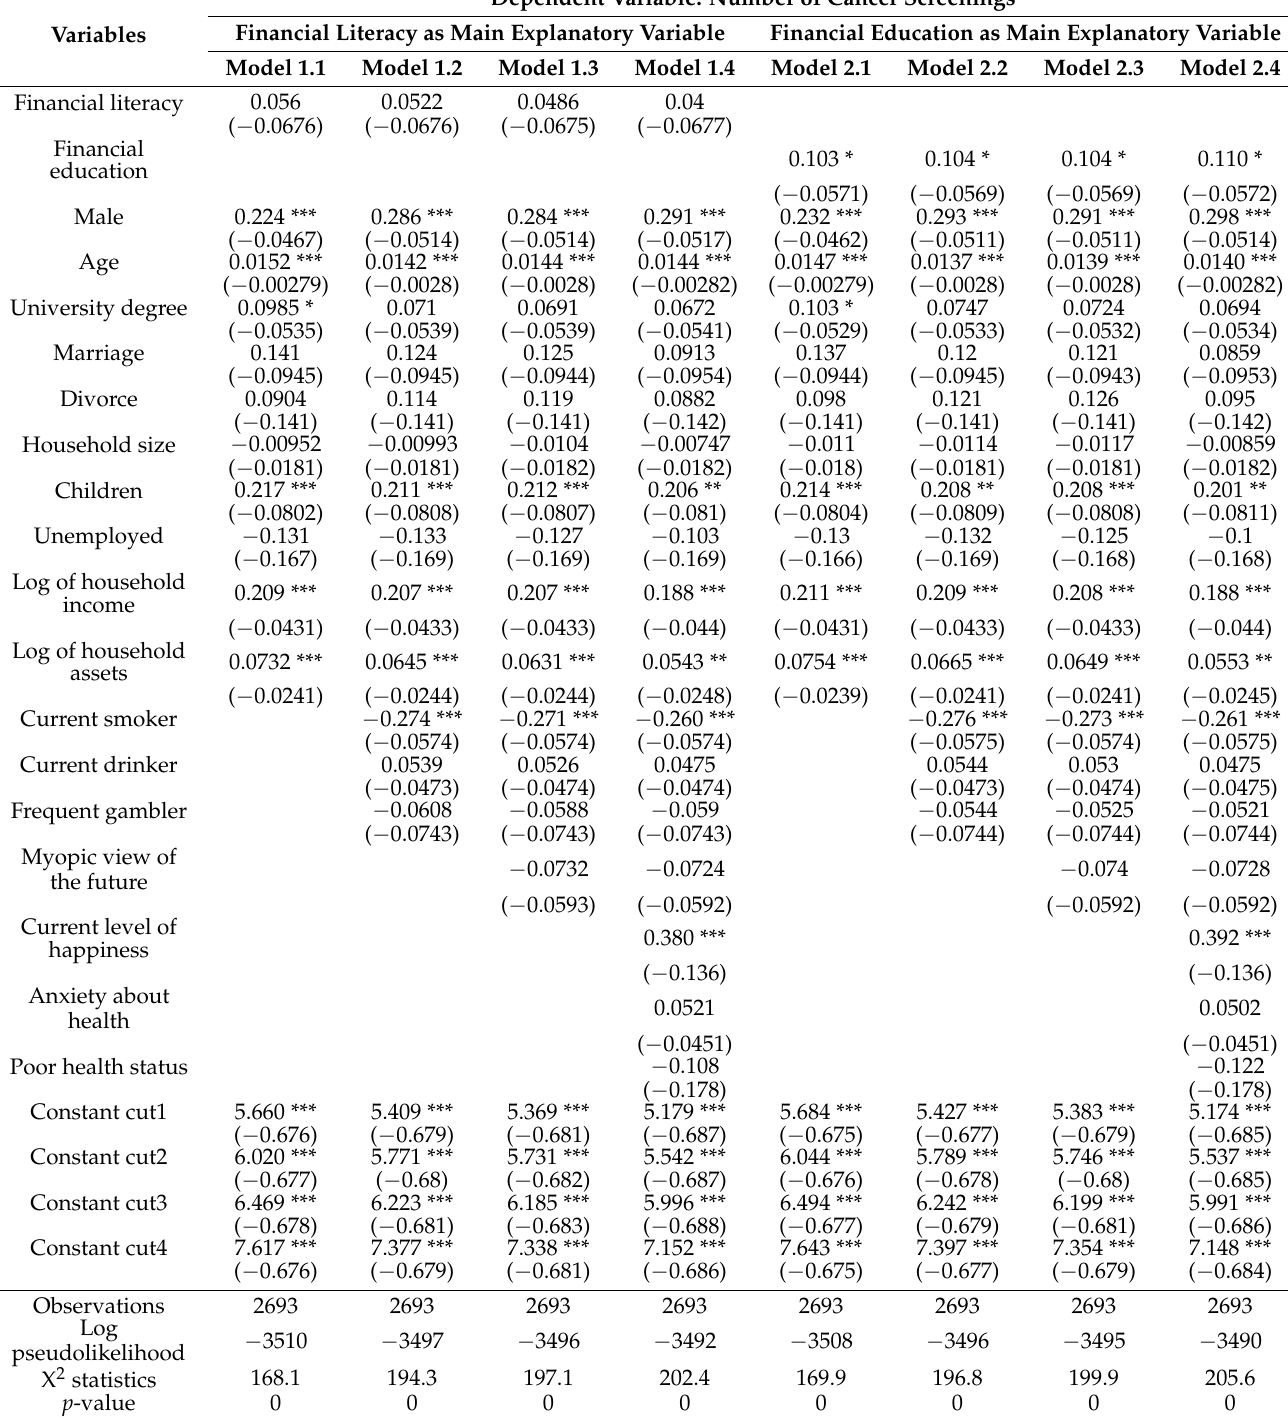
Table 7. Ordered probit model regression results with either financial literacy or financial education as the main explanatory